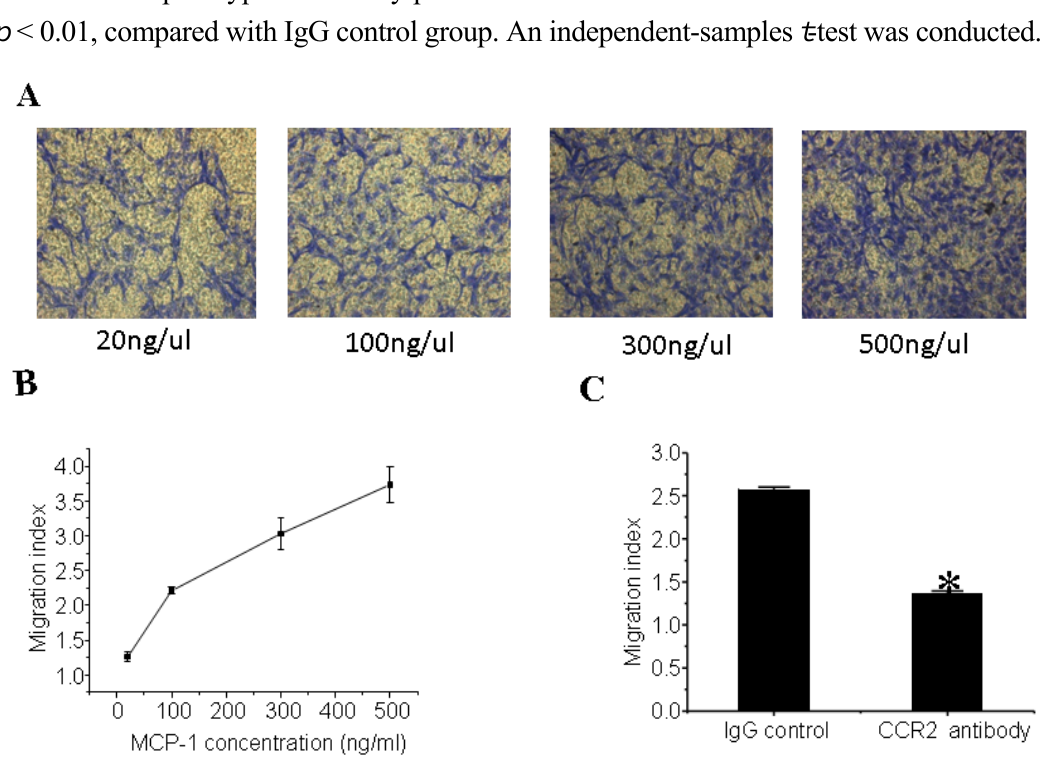
Figure 5. Monocyte Chemotactic Protein-1 (MCP-1) causes mesenchymal stem cells (MSCs) chemotaxis in vitro ; ( A ) Representative photographs of migrated MSCs staining with crystal violet. The migration of MSCs is dose-dependently increased upon MCP-1 treatment; ( B ) MCP-1 treatment dose-dependently promotes MSCs migration; ( C )